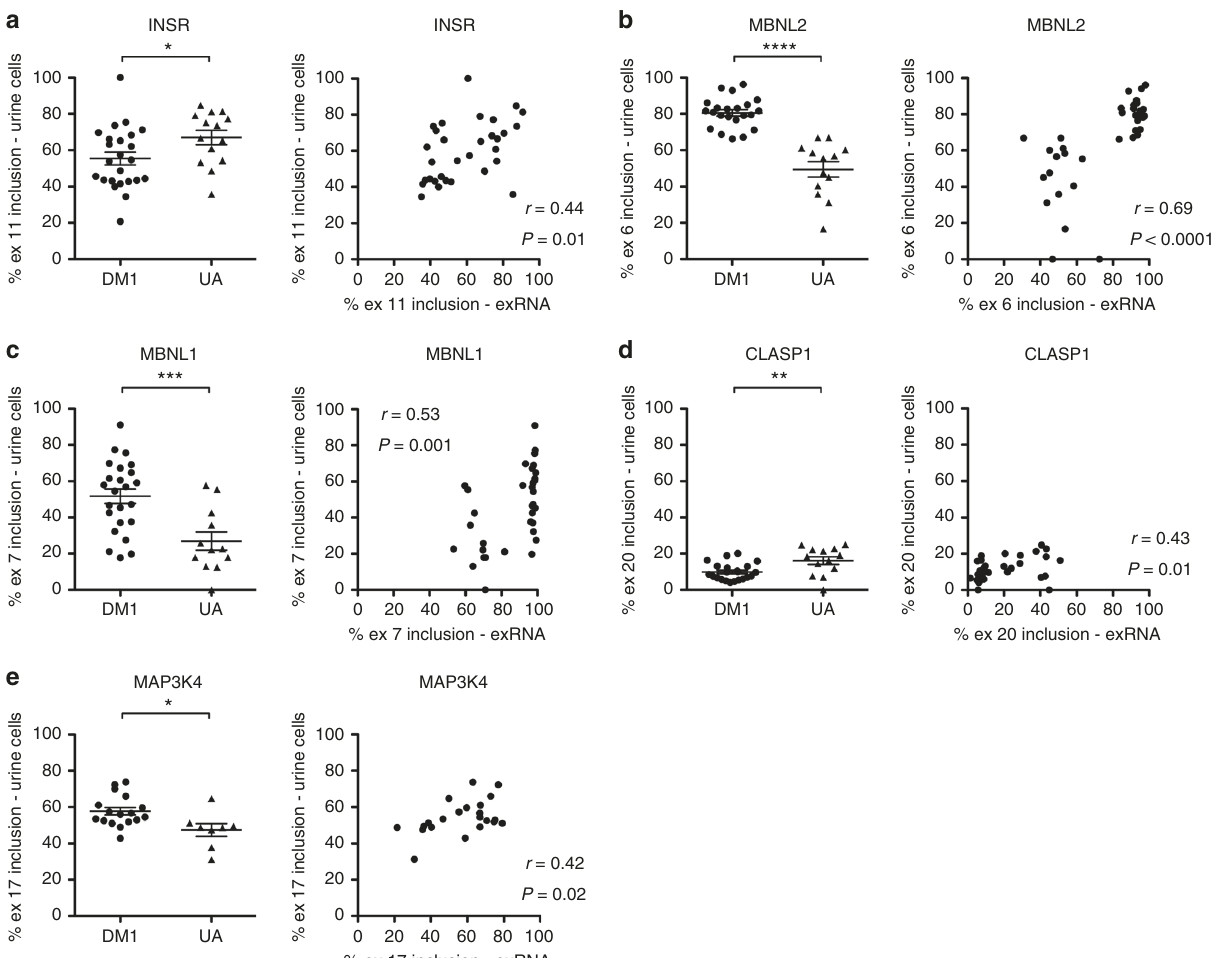
Fig. 8 ddPCR analysis of alternative splicing in urine cell total RNA and correlation with splicing in urine exRNA. We used ddPCR to determine the alternative splicing pattern in urine cell RNA of DM1 ( N = 22 – 24) and UA ( N = 12 – 14) subjects and correlated with splicing patterns in exRNA obtained from the same sample. a Left, INSR exon 11 inclusion in urine cell total RNA. * P = 0.04; t test. Right, correlation of INSR exon 11 inclusion in urine cells with exon 11 inclusion in urine exRNA. The correlation coef fi cient r and P values are shown. b Left, MBNL2 exon 6 inclusion in urine cell total RNA. Note that values for two DM1 and one UA specimen were undetectable. **** P < 0.0001; t test. Right, correlation of MBNL2 exon 6 inclusion in urine cells with exon 6 inclusion in urine exRNA. The correlation coef fi cient r and P values are shown. c Left, MBNL1 exon 7 inclusion in urine cell total RNA. Note that values for one DM1 and two UA specimens were undetectable. *** P = 0.0008; t test. Right, correlation of MBNL1 exon 7 inclusion in urine cells with exon 7 inclusion in urine exRNA. The correlation coef fi cient r and P values are shown. d Left, CLASP1 exon 20 inclusion in urine cell total RNA. Note that values for two DM1 and one UA specimen were undetectable. ** P = 0.005; t test. Right, correlation of CLASP1 exon 20 inclusion in urine cells with exon 20 inclusion in urine exRNA. The correlation coef fi cient r and P values are shown. e Left, MAP3K4 exon 17 inclusion in urine cell total RNA. Note that, due to exhaustion of supply, only N = 17 DM1 and N = 8 UA specimens were available for analysis. * P = 0.01; t test. Right, correlation of MAP3K4 exon 17 inclusion in urine cells with exon 17 inclusion in urine exRNA. The correlation coef fi cient r and P values are shown. All error bars indicate mean ±